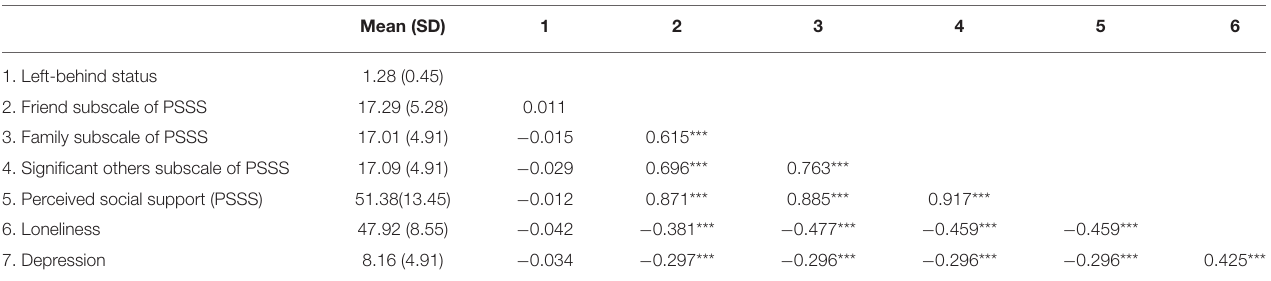
TABLE 3 | Descriptive statistics and correlations among variables ( N = 826).